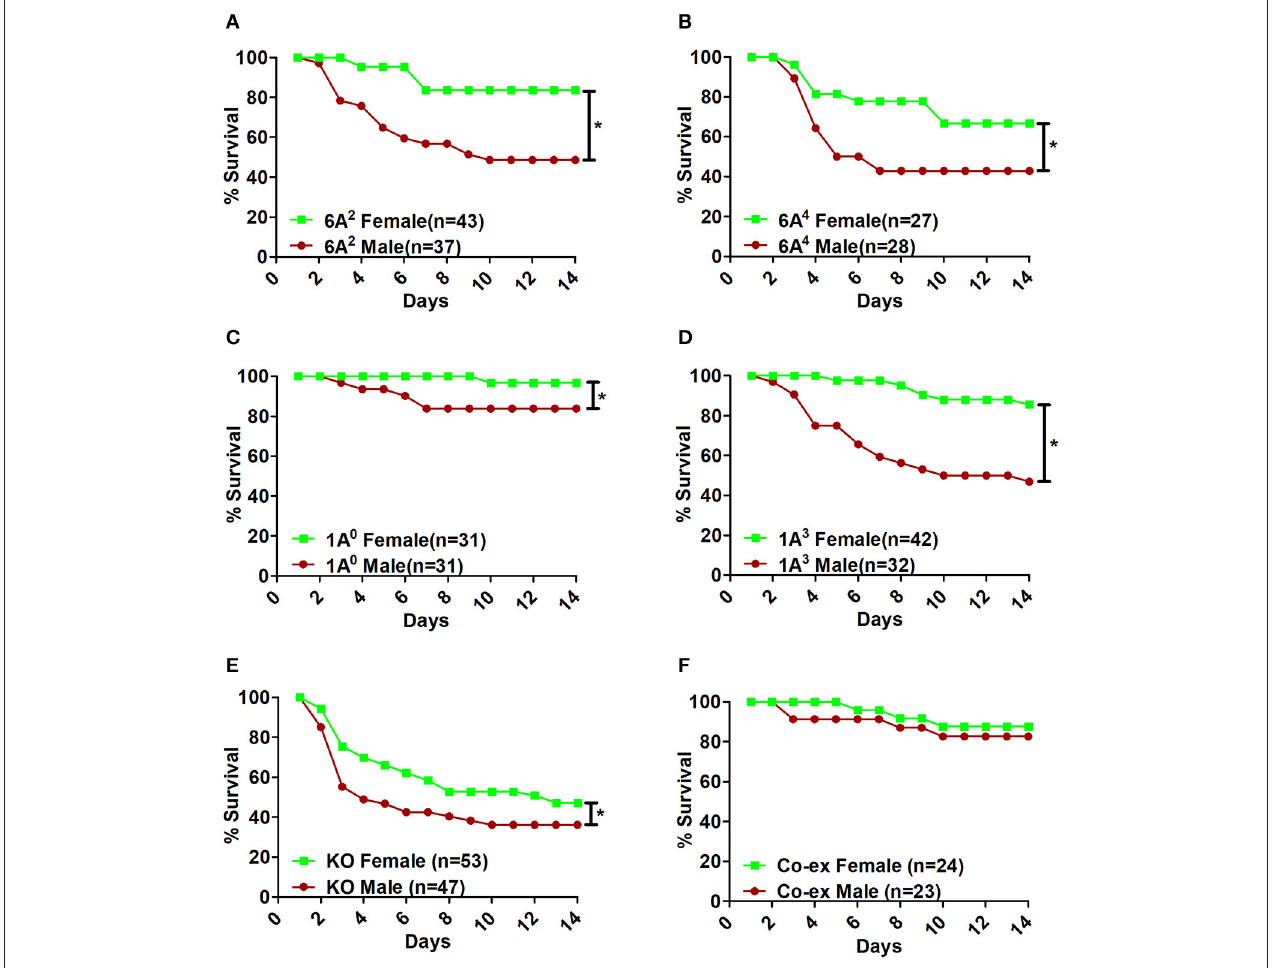
FIGURE 2 | Effect of sex on survival after K. pneumoniae infection. The survival rate was measured in SP-A1 (6A 2 , 6A 4 ) (A,B) , SP-A2 (1A 0 , 1A 3 ) (C,D) , SP-A KO (E) , and SP-A1/SP-A2 [6A2/1A 0 , (co-ex)] (F) male and female mice over a period of 14 days after infection. Significant differences for survival are indicated * p < 0.05. The number of mice used in each group is shown in Figure panels in parenthesis ( n =